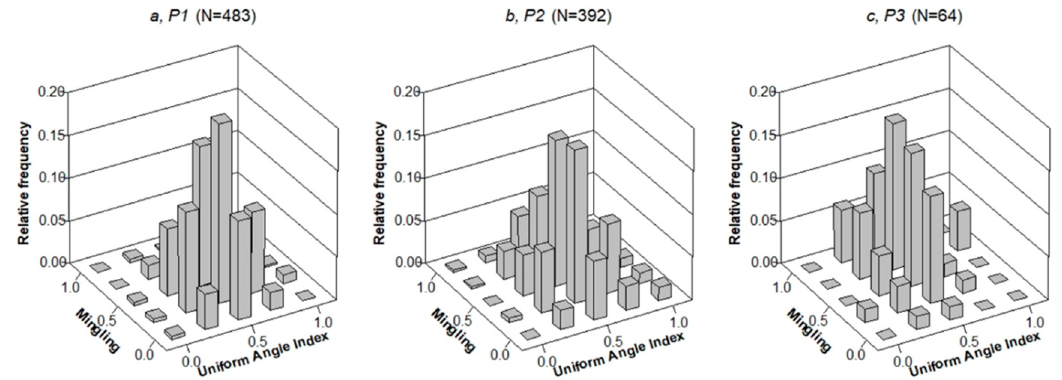
Figure 5. Bivariate distributions of mingling versus uniform angle index on three sample plots P1 ( a ), P2 ( b ) and P3 ( c ). N: number of S. macrophyllus individuals.